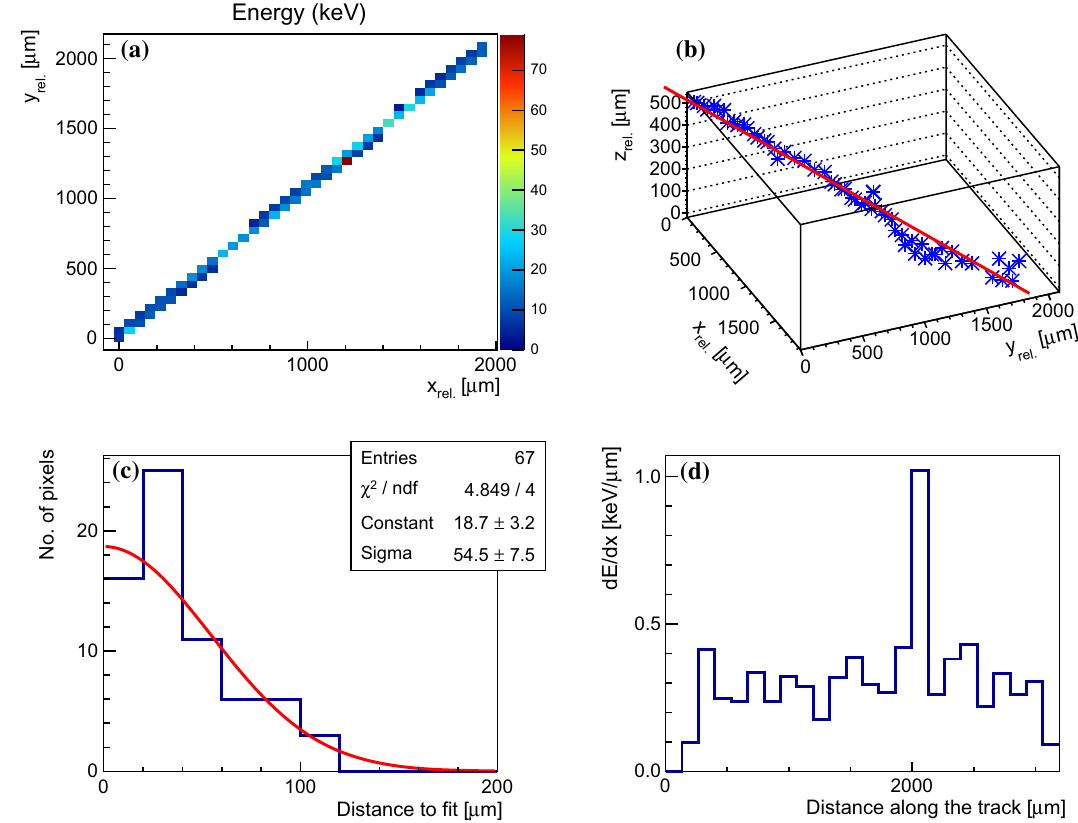
Fig. 13 Cosmic muon track measured in the laboratory. The bias voltage was set to 230V. a The energy projection; b a fit to the reconstructed particle trajectory; c the distances of each point to the fit; d the energy depositions along the